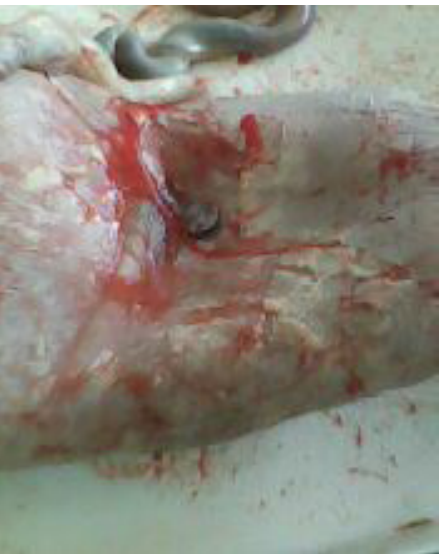
Figure 5. Photograph of the groin area showing the undetermined extern a l genitalia, and absent urinary